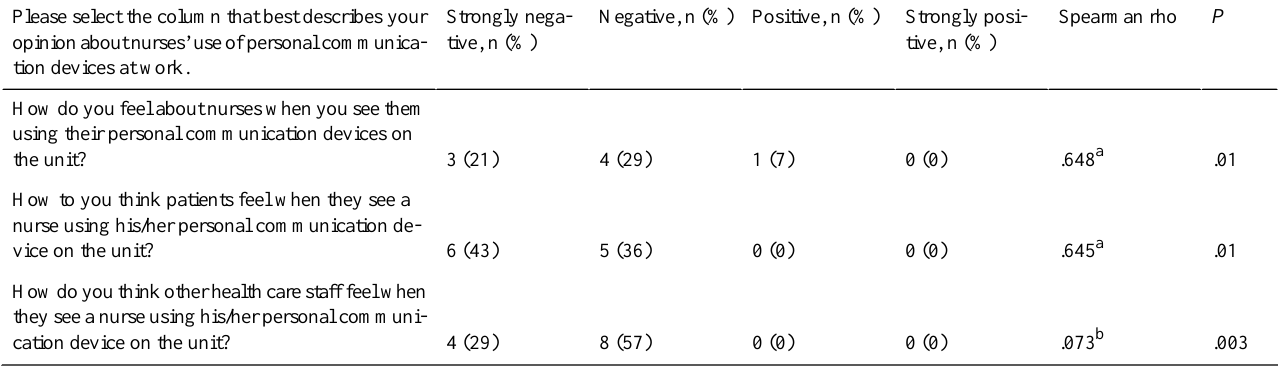
P Spearman rhoStrongly posi-